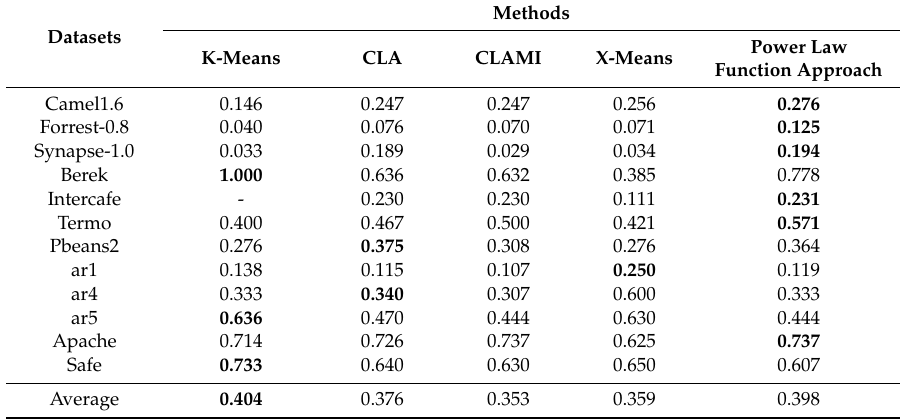
Table 4. Comparisons of precision results between the proposed approach and other methods.